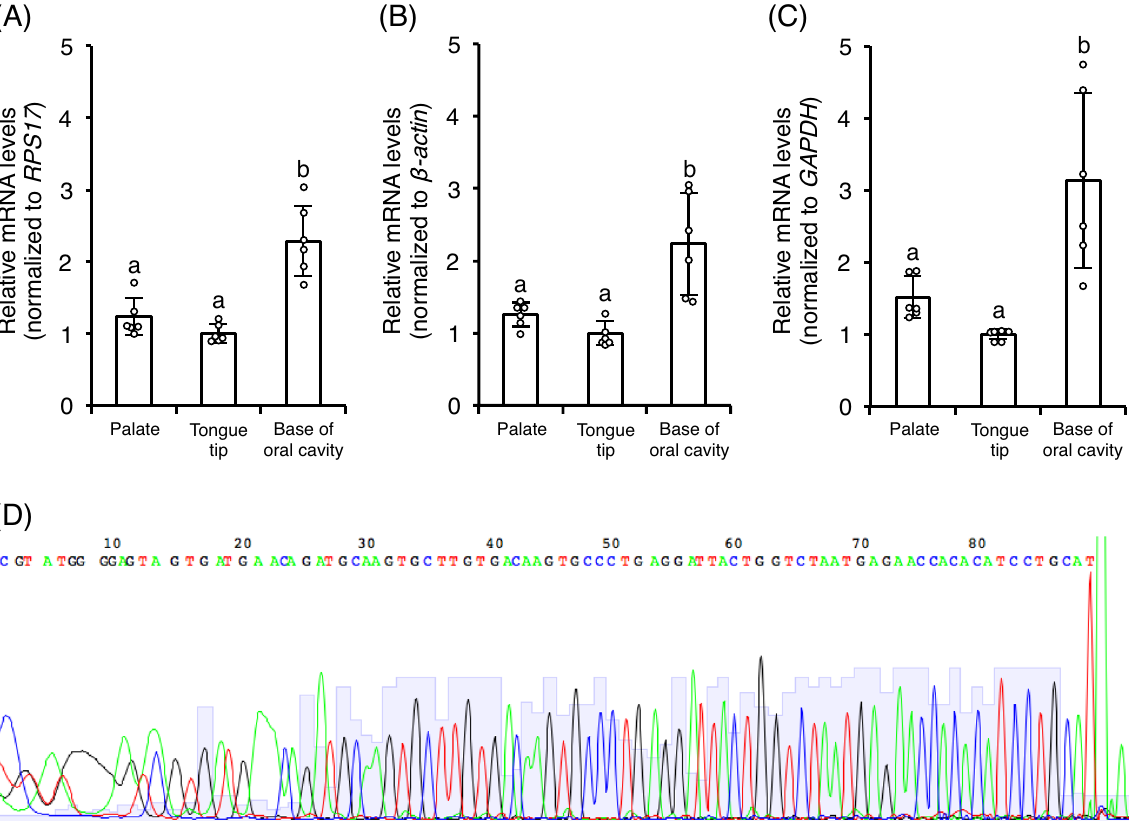
Figure 1. The relative mRNA levels of CaSR were significantly higher in the base of oral cavity than in the palate and the tongue tip in chickens. Values are the mean relative mRNA levels (normalized to ( A ) RPS17 , ( B ) β-actin , and ( C ) GAPDH ) ± SD (n = 6). Bars without a common letter differ significantly, P < 0.01 by one-way factorial ANOVA followed by post-hoc Tukey HSD test. ( D ) Representative sequence analysis data of the RT- q PCR product of the base of oral cavity by using CaSR primer